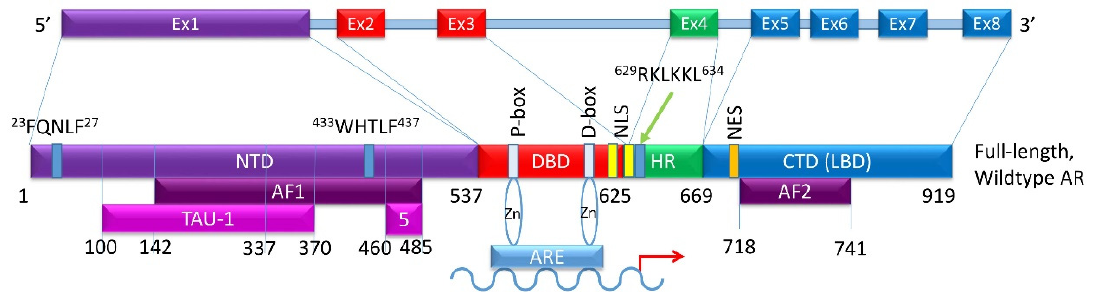
Figure 2. Schematic of the canonical full-length wild type AR exons and the domains they encode. ( Top ) Exon structure of the AR gene. ( Bottom ) Protein domains of the full-length wild-type AR showing which exon encodes for which domain. Additional minor domains are also indicated. The P-box and the D-box identify two zinc-fingers that directly find to the ARE on the target gene.